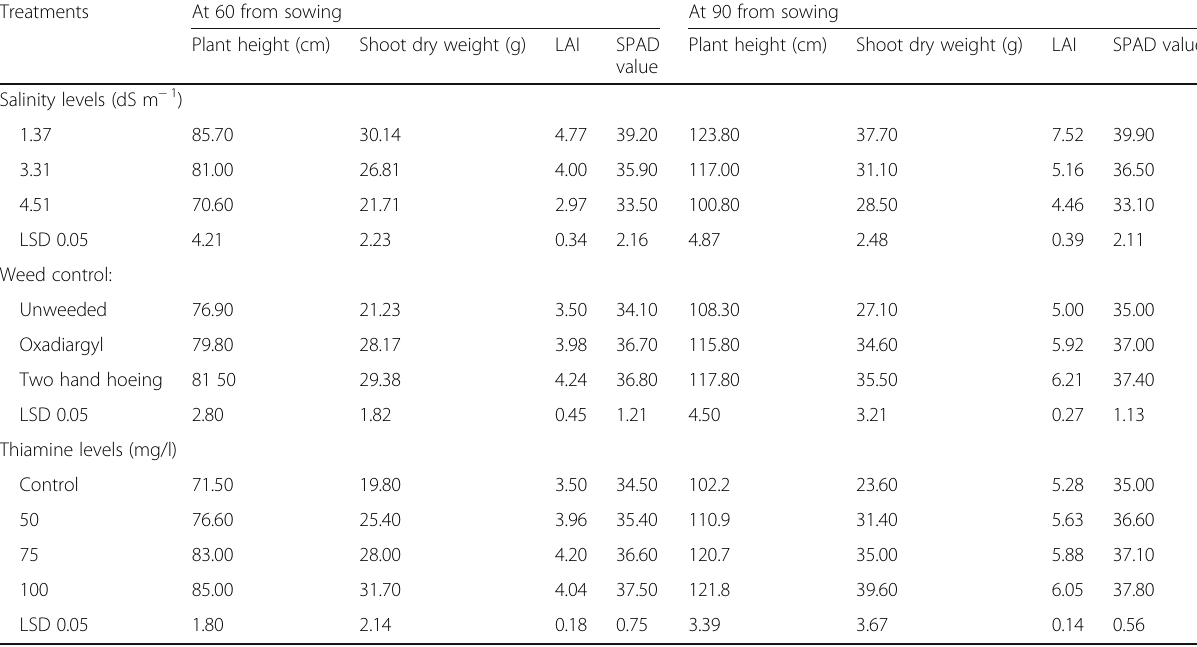
Table 3 Effect of weed control and thiamine levels on growth and physiological characters of faba bean under salinity condition after 60 and 90 days from sowing (combined analysis of two seasons) Treatments At 60 from sowing At 90 from sowing Plant height (cm) Salinity levels (dS m − 1